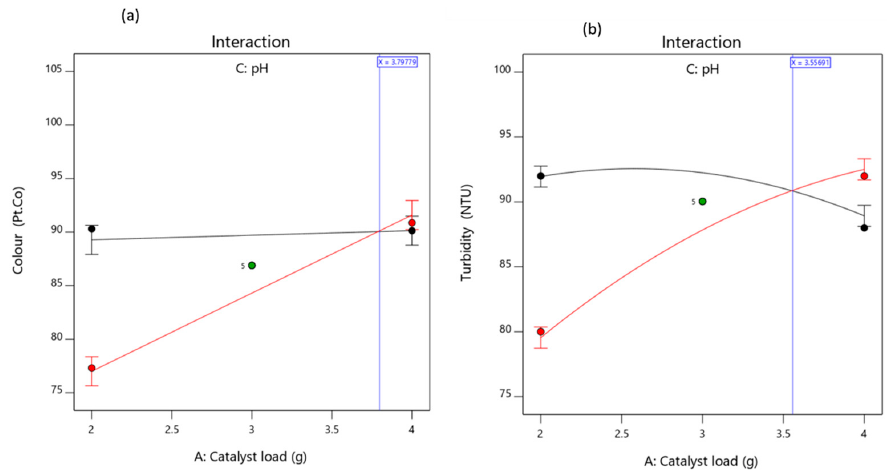
Figure 5. Interactive effect of catalyst load and pH on ( a ) color and ( b ) turbidity removal.